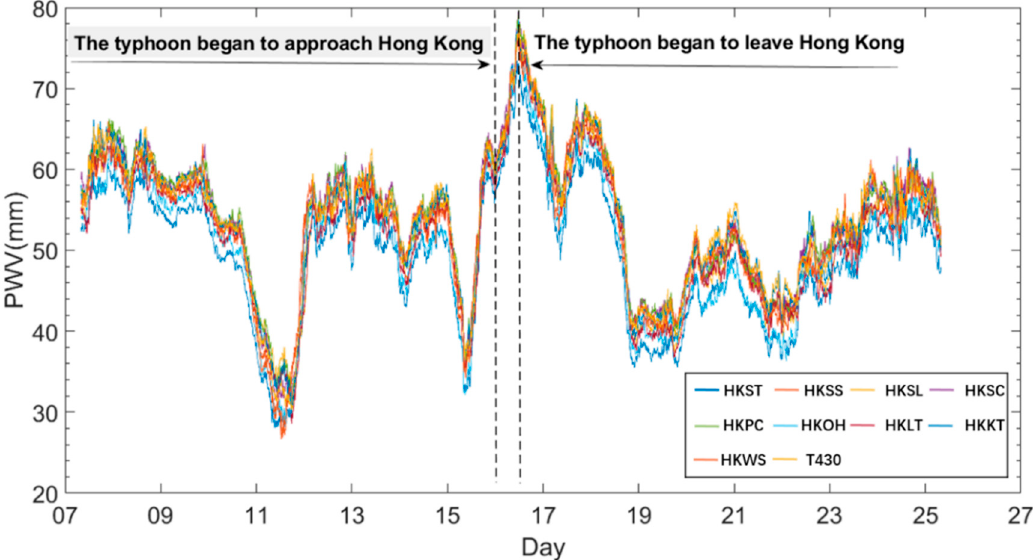
Figure 9. Time series of 3-min GNSS-PWV over each of the 10 selected GNSS stations during the period of 7 – 25 September.